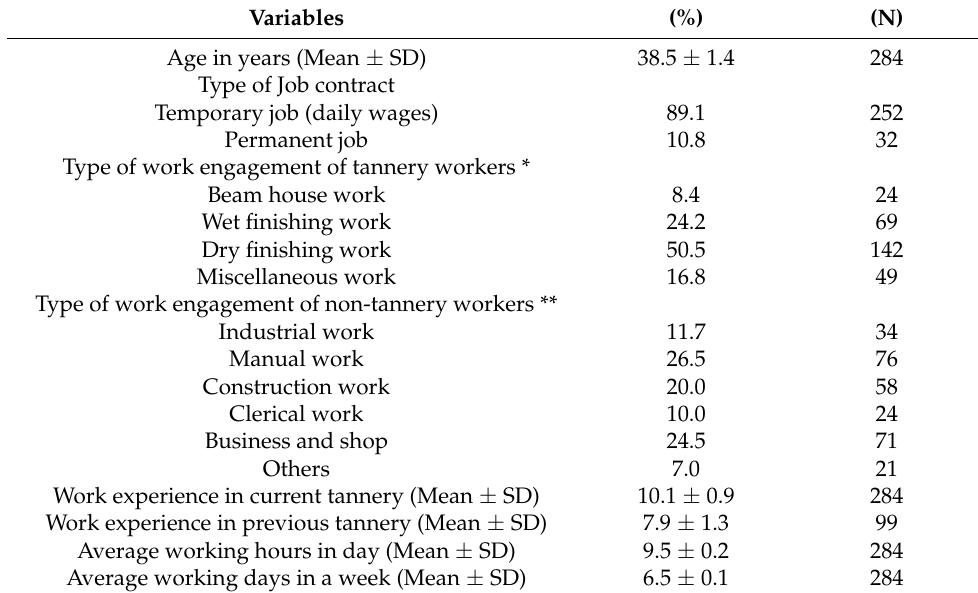
Table 2. Work-related characteristics of tannery workers in Kanpur, India,